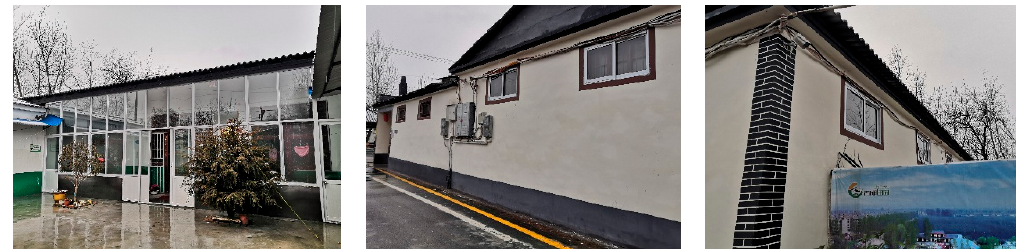
Figure 25. The transformed Rural House 2.